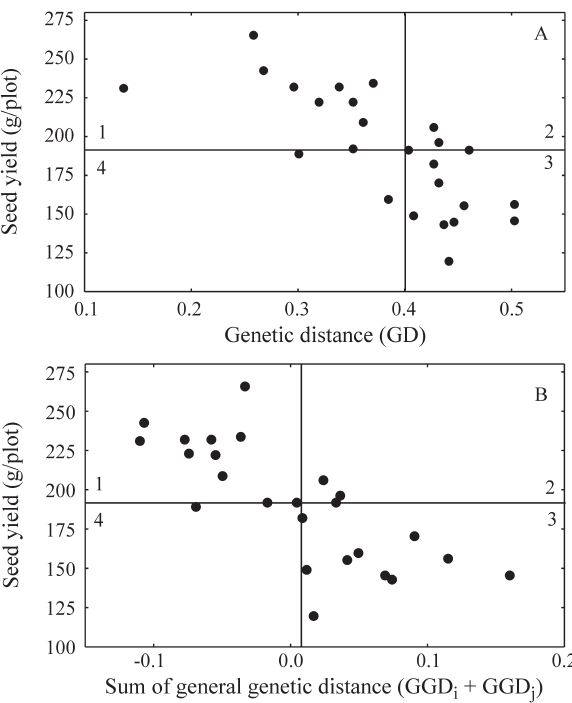
Figure 2 - Relationship between population means for seed yield as esti- mated in the combined analysis with (A) genetic distances (GD) and (B) the sum of general genetic distances (GGD i + GGD j ). Quadrants are num- bered 1-4 (see text for